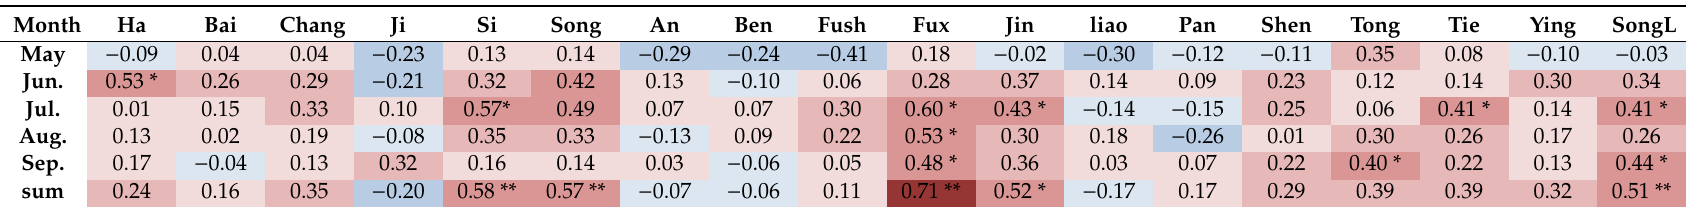
Table 2. Pearson’s correlation coe ffi cient of temperature and climate yield in maize growing season in Songliao Plain maize belt during the period 1998–2017. Month Ha Bai Chang Ji Si Song Tie Ying SongL May − 0.20 − 0.11 Aug. − 0.20 Sep. − 0.22 − 0.20 − 0.08 − 0.28 − 0.12 mean − 0.33 − 0.48 *